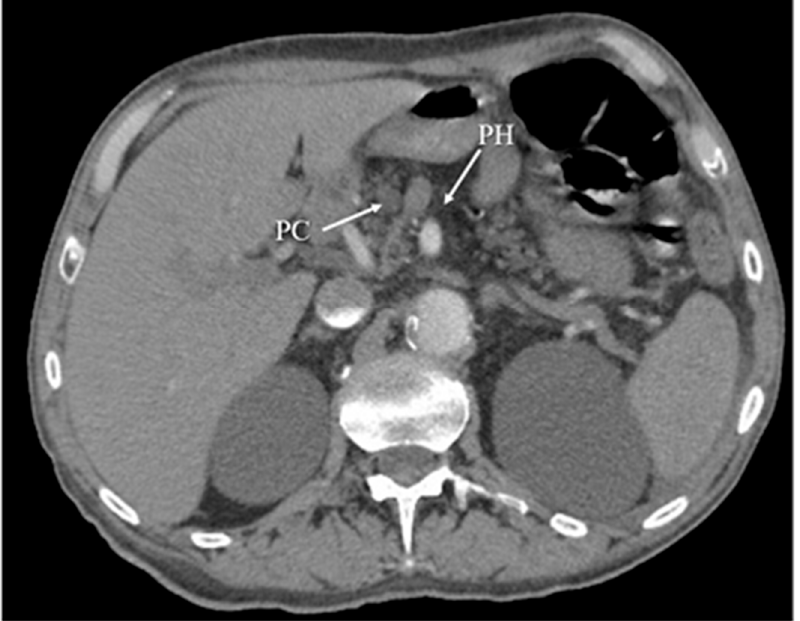
Figure 5. Chronic pancreatitis, with atrophy of pancreatic head (PH) parenchyma and pseudocyst (PC) in this region. The arterial phase of CT.